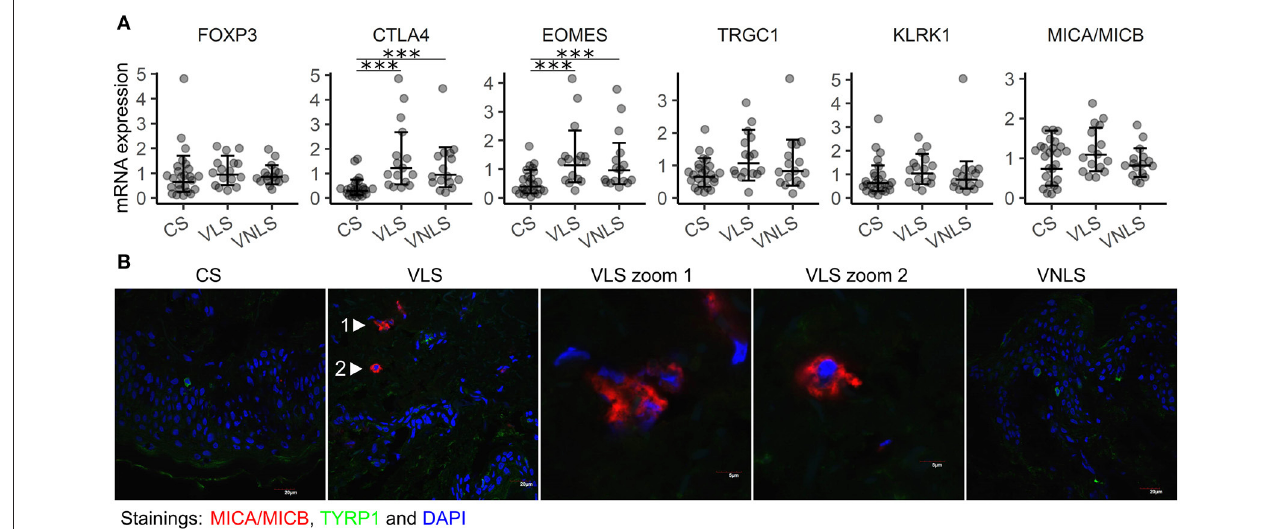
FIGURE 3 | Innate-like cells and receptors are involved in vitiligo pathogenesis. (A) Relative mRNA expression of genes encoding markers of infiltrating immune cells and their target molecules. Geometric mean ×÷ geometric standard deviation is indicated. *** p < 0.001. (B) Immunofluorescence image of MICA/MICB (MHC class I chain-related protein A and B) and TYRP1 (tyrosinase related protein 1) in sections of biopsy samples from control subjects (CS), and in the lesional skin (VLS) and non-lesional skin (VNLS) of vitiligo patients. The images are representative of 3 healthy controls and 3 vitiligo